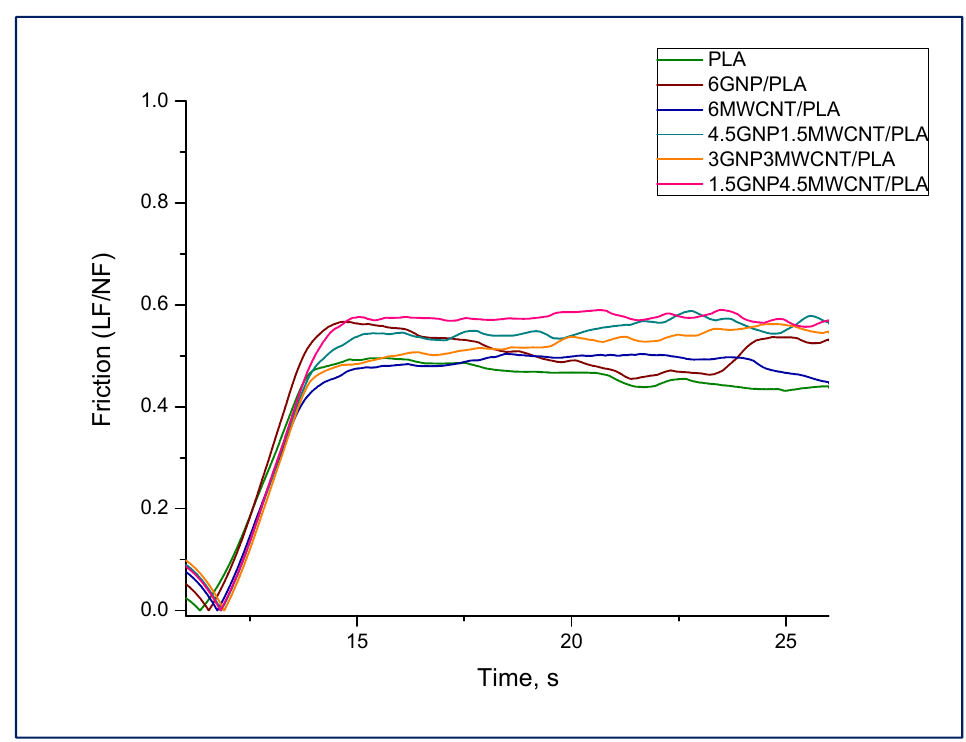
Figure 5. Friction behavior at nanoscratch testing of monofiller and bifiller nanocomposites including pure PLA as a reference.